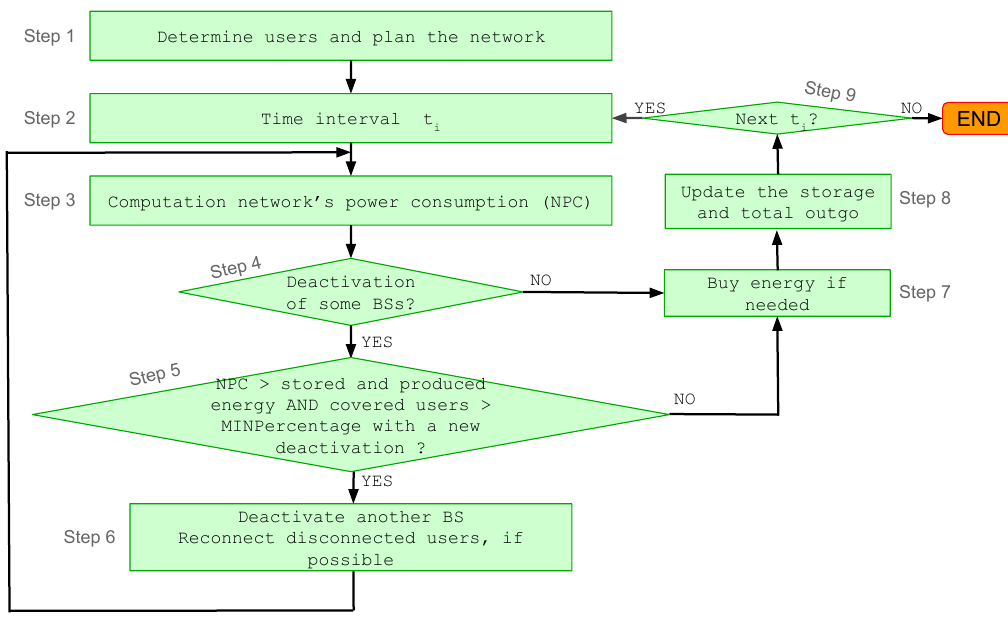
Figure 7. Flowchart when using the Only Microcell BSs: No Action or Only Microcell BSs: Deactivation of some BSs